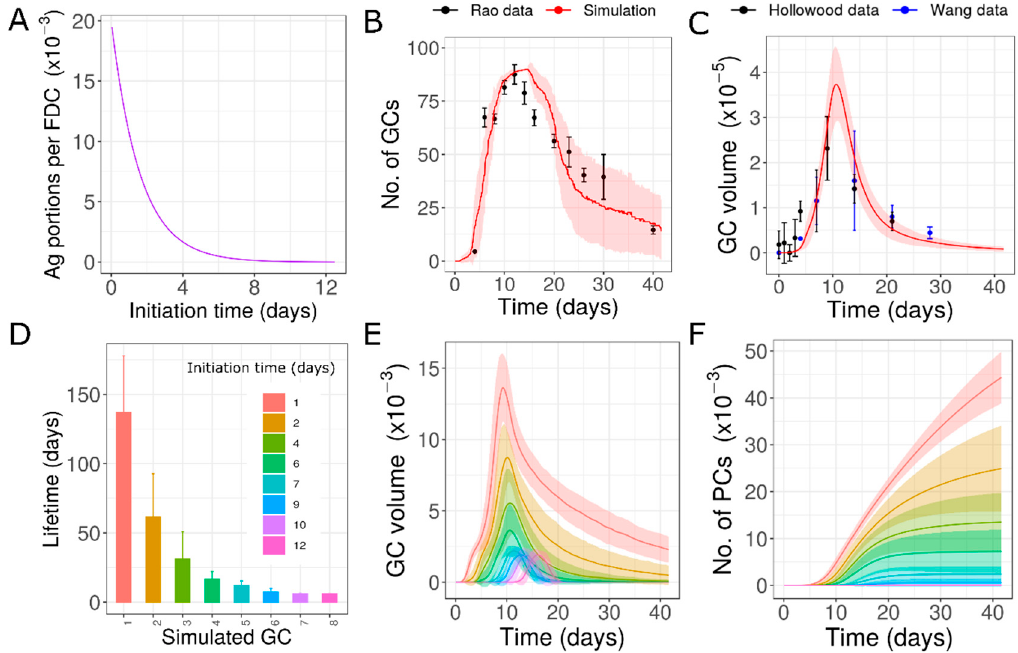
Figure 4. Simulations of GCs with antigen concentration depending on the time of appearance of GCs: ( A ) exponential function used to determine the antigen amount loaded in GCs as a function of starting time, ( B ) dynamics of number of GCs, ( C ) dynamics of total GC volume, ( D ) lifetime of simulated GCs, ( E ) GC volume of individual GCs simulated, ( F ) plasma cells produced from simulated individual GCs. In Panels D, E, and F, GCs initialized at different time points are shown in different colors. Experimental data from [13,31,45]. GC: germinal center; PC: plasma cell.